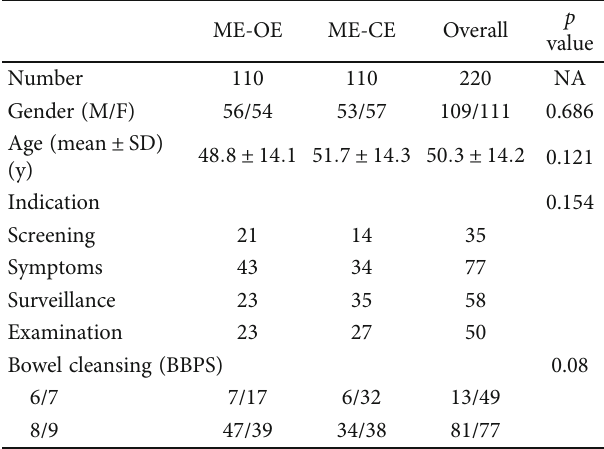
Table 1: Clinical characteristics of the subject